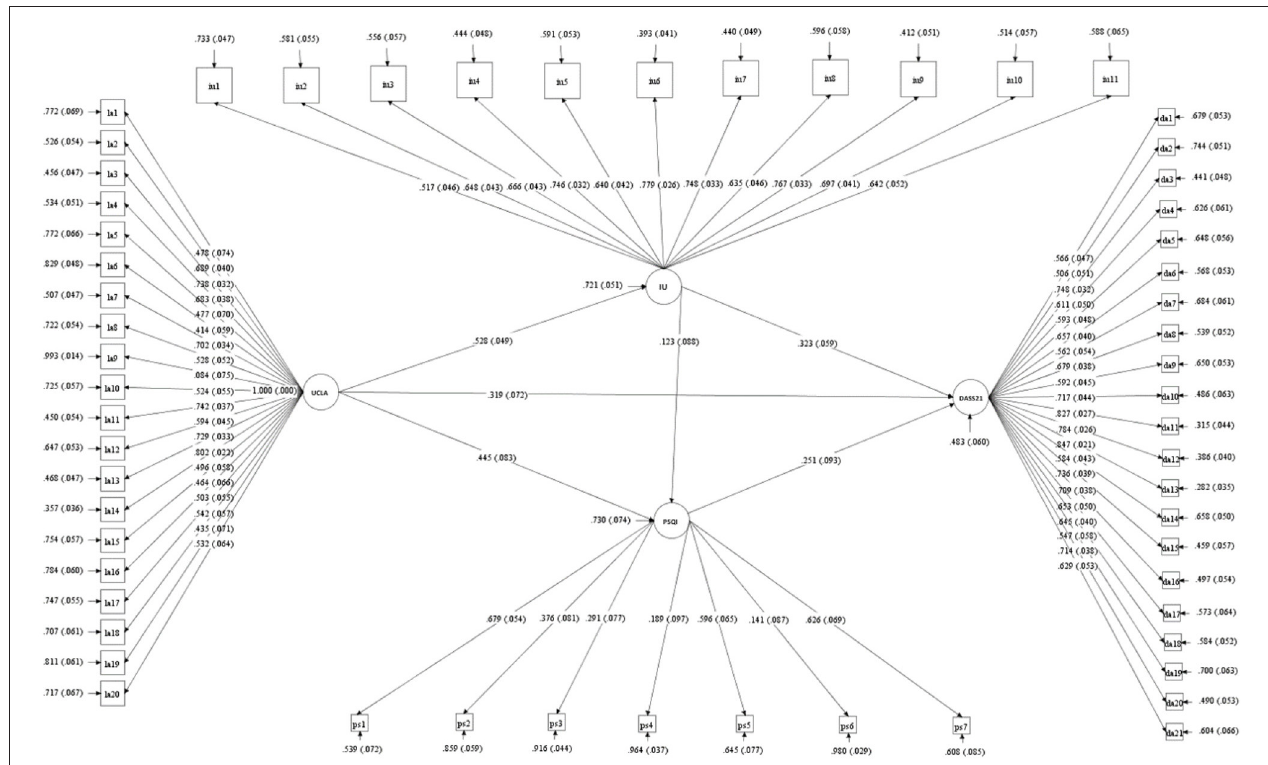
FIGURE 5 | The latent variables and their corresponding explicit variables in the model. UCLA by la1-la20; IU by iu1-iu11; PSQI by ps1-ps7; DASS-21 by da1-da21.